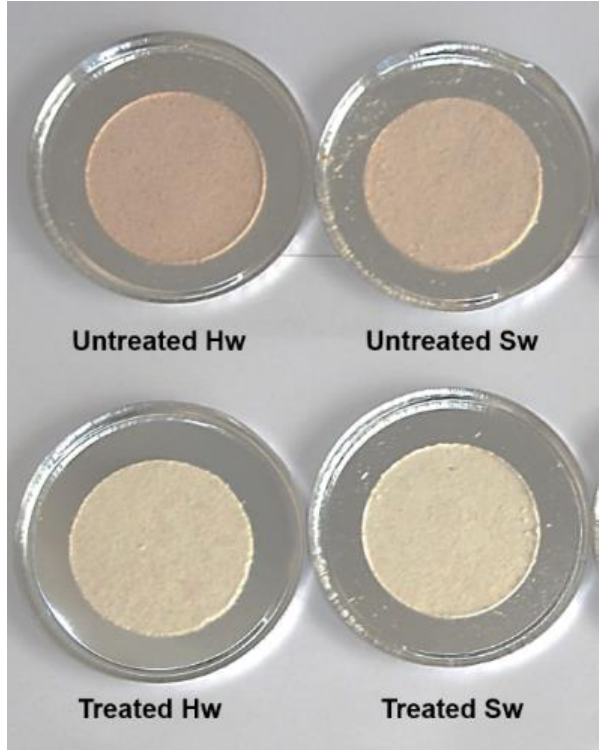
Figure 3. Maritime pine heartwood and sapwood discs before and after H 2 O 2 treatment. Color homogenization was attributed to two